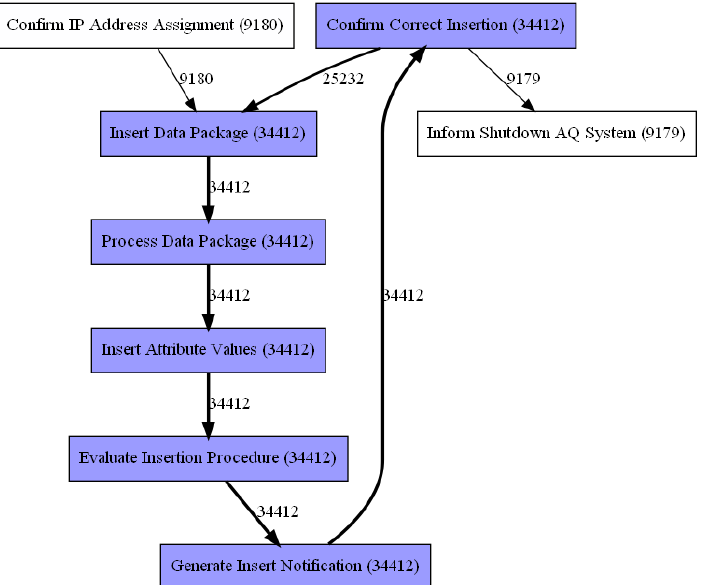
Figure 6. BPMN process model discovered using Split-miner for IoT Air Quality Monitor participant event log.